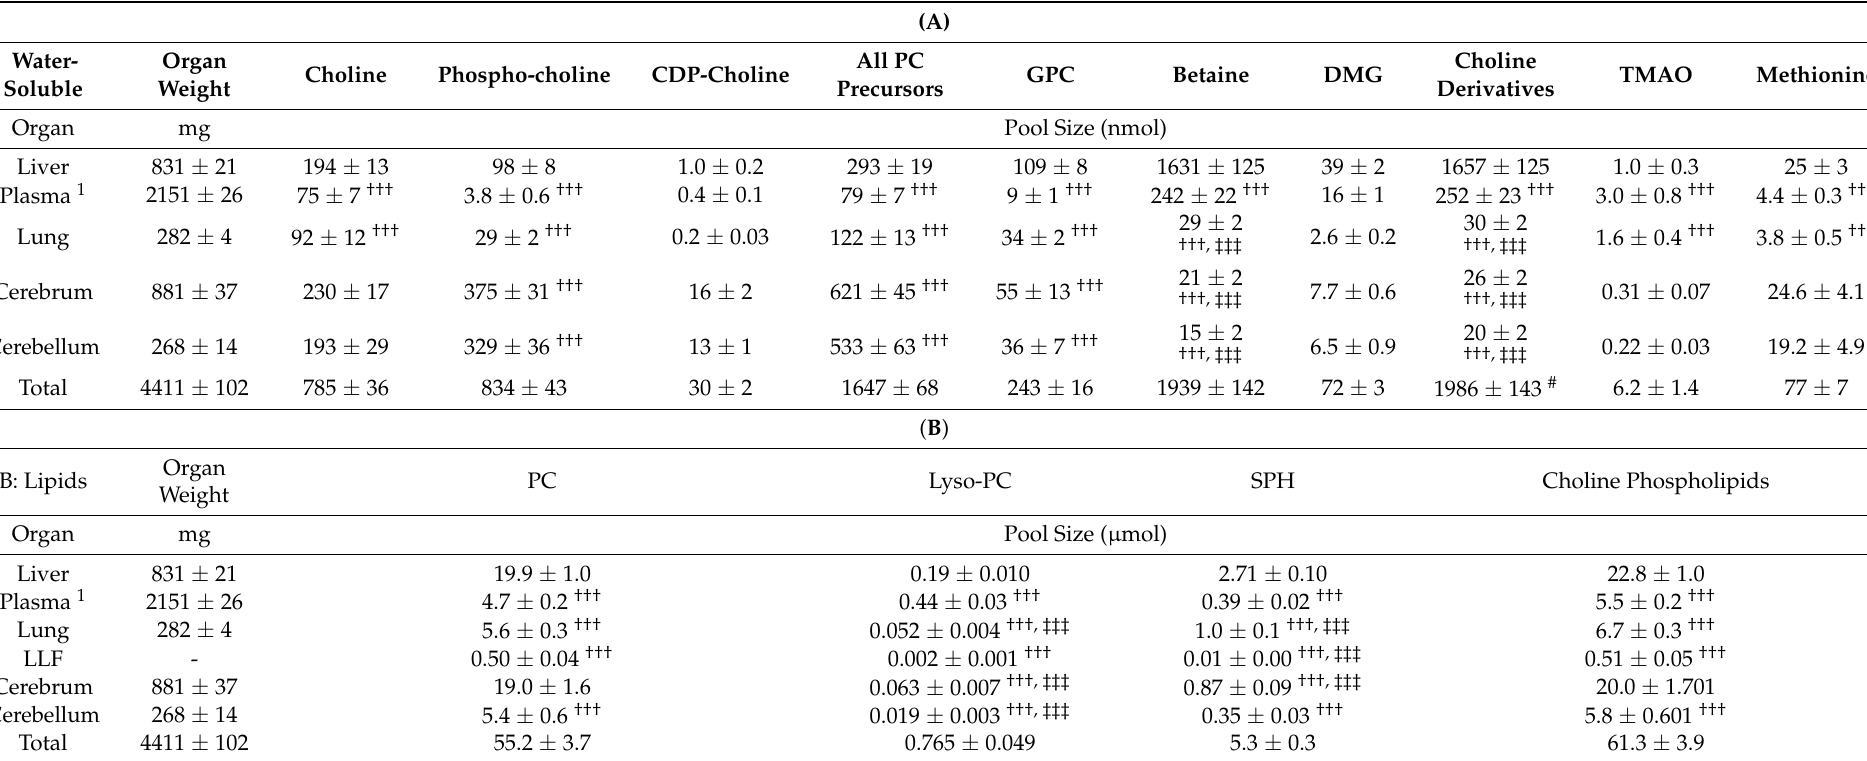
Table 1. Pool Sizes of Endogenous (Unlabeled) Choline, Choline Metabolites and Choline-containing phospholipids.